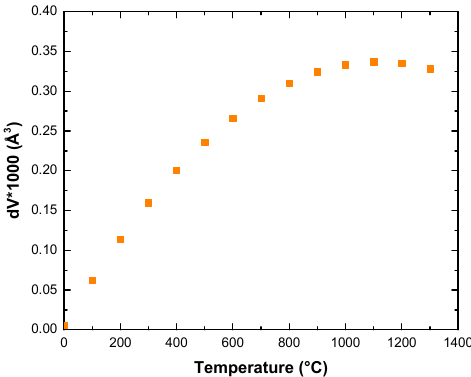
Figure 6. Difference between lattice volume of geikielite in GK sample in this work + references [7,8] and the GQ sample in this work + reference [5] as function of temperature (using calculated data).